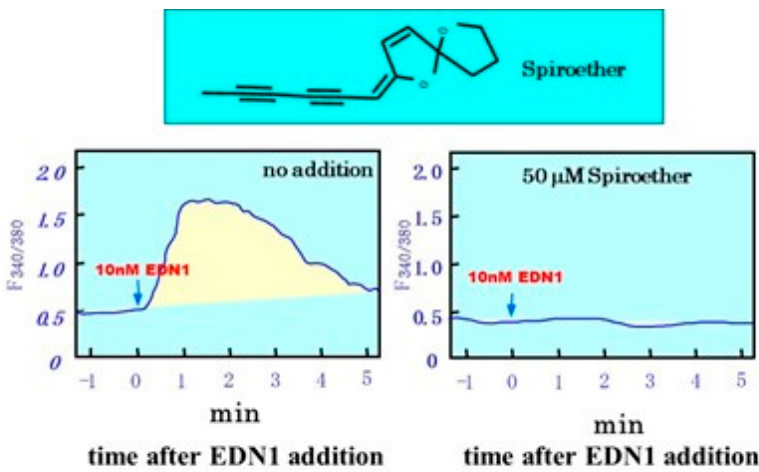
Figure 6. Inhibitory effects of spiroether on EDN1 induced intracellular calcium mobilization [1].